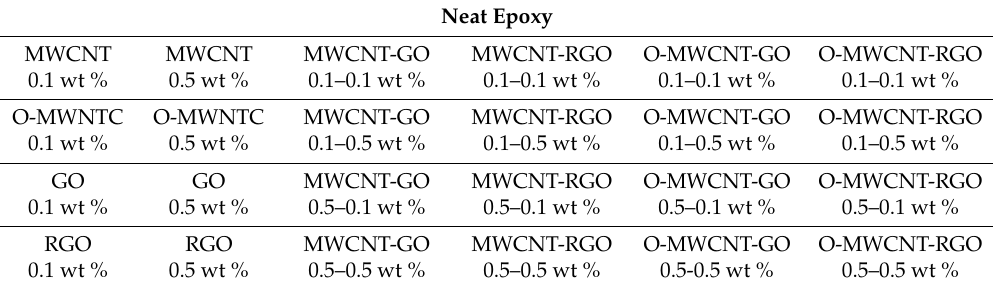
Nomenclature for Multidimensional (MD) and Multilayer-Multidimensional (ML) nanocomposites according to the quantities and type of added 1D and 2D